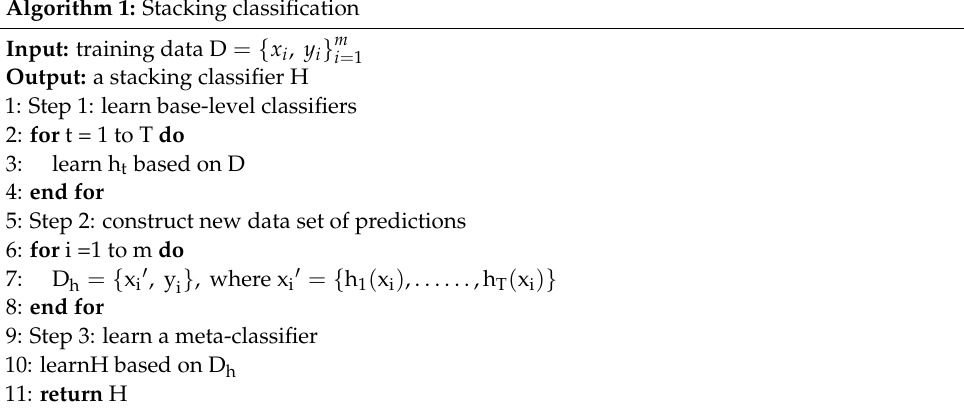
Algorithm 1: Stacking